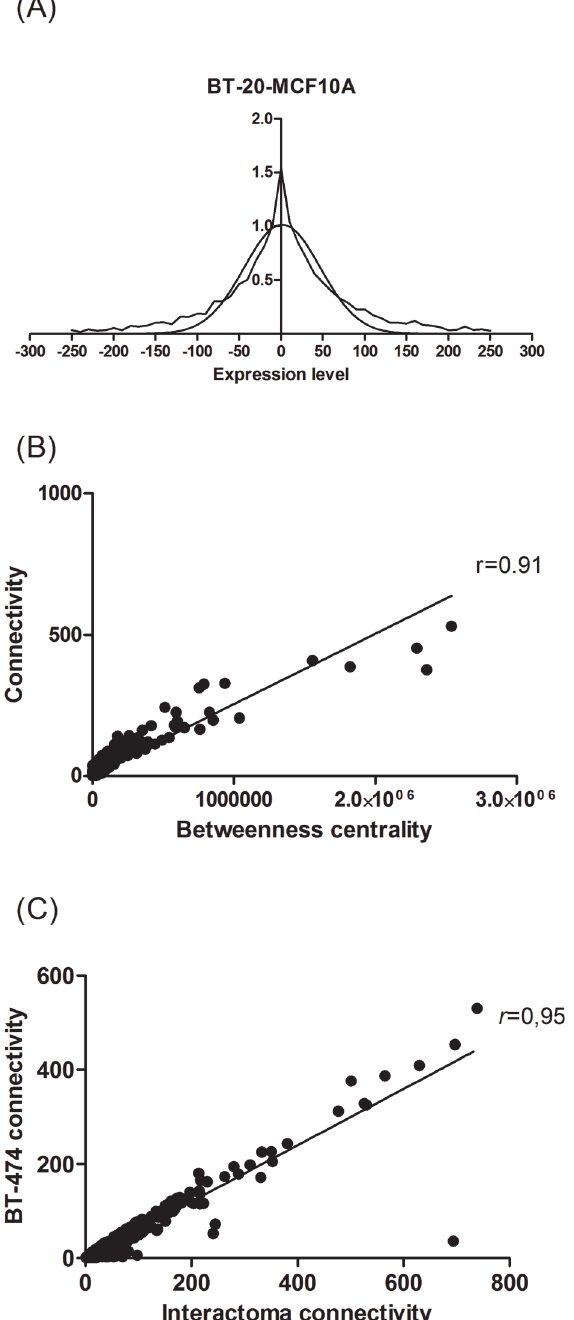
Figure 1. (A) Gaussian distribution of differential expressed genes between BT-20 and MCF10A. (B) Correlation between connectivity and betweenness centrality . (C) Correlation between the connectivity of proteins considering the full network sample available ( * 10,000) and sub-networks of * 600 proteins in BT- 474 breast cancer cell lines.